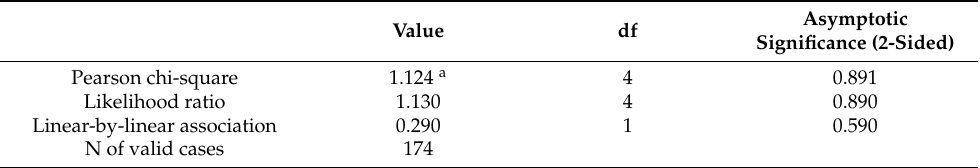
Table 5. Chi-square tests for the face-to-face communication preference.